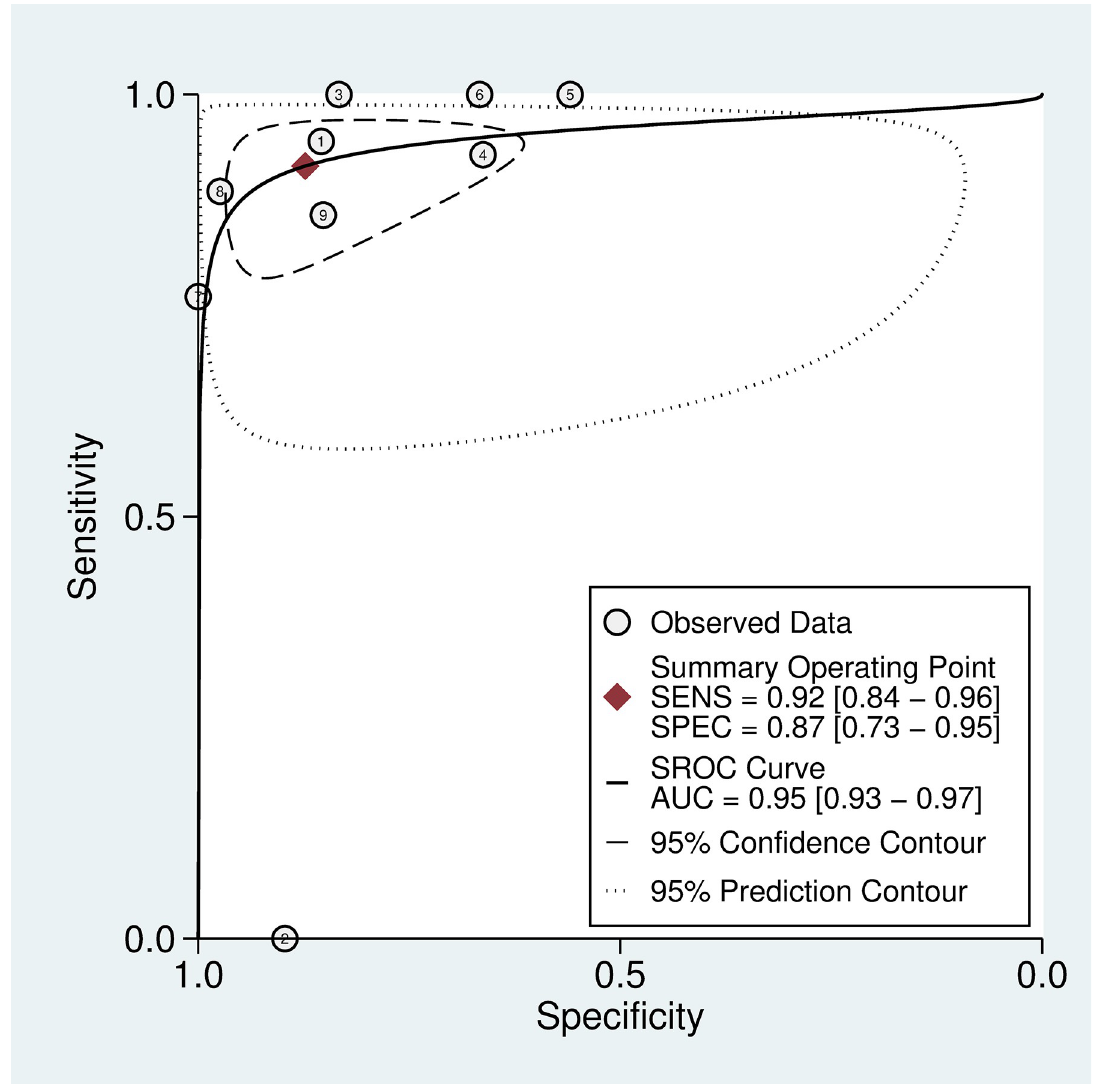
Fig 8. SROC curve for 20WBCT at detecting coagulopathy. SROC curves for 20WBCT at detecting severe coagulopathy defined as INR > 5 or fibrinogen < 50 mg/dL.